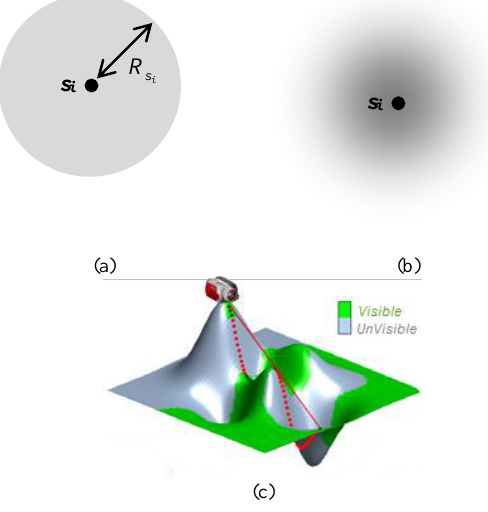
Figure 1. The spatial coverage of a sensor: (a) 2D simple sensing model; (b) 2D variable sensing model; (c) Sensing model of sensor in a 3D environment by considering the visibility through line of sight and viewshed analysis